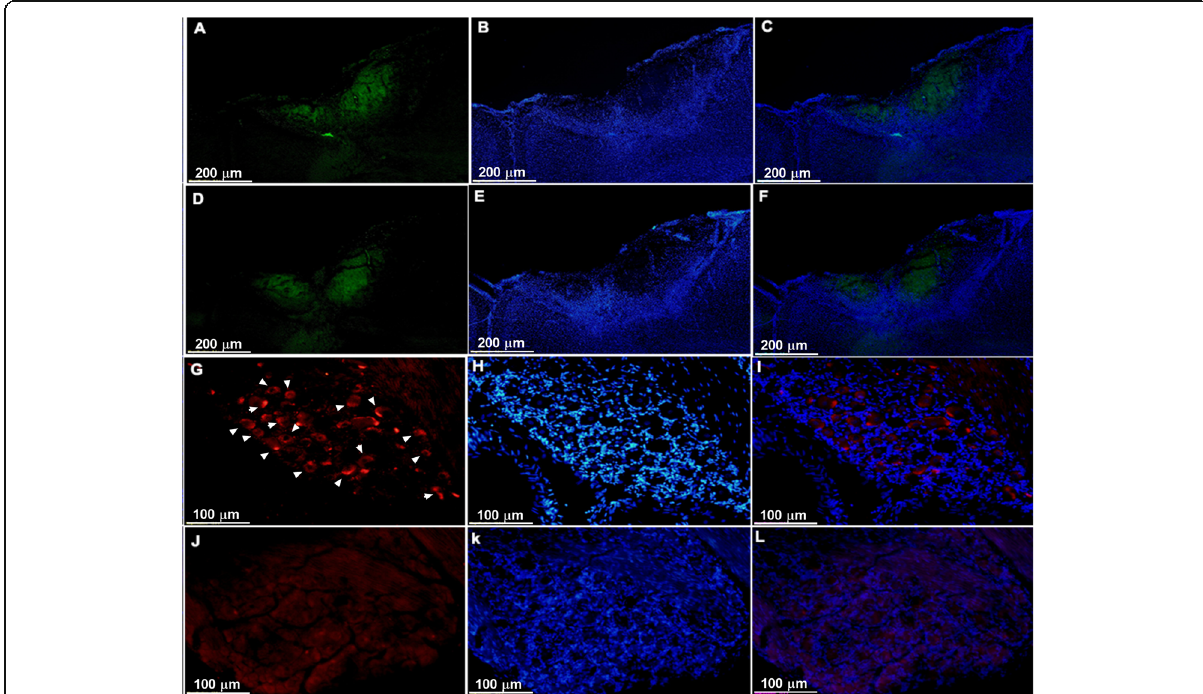
Fig. 7 Immunofluorescence results for viral expression in the primary motor cortex ( a - f ) and CGRP neuron expression in the trigeminal ganglion ( g - l ). a , b , c Optogenetic viral expression in the motor cortex of TN-Opto animals. d , e , f Null viral expression in the motor cortex of TN-Null animals. a , d EYFP, b , e DAPI, and c , f Merge. Scale bar = 200 μ m. g - l PBS and α -CGRP-injected and DAPI-stained trigeminal ganglion cells. g-i Presence of anti-CGRP antibody binding due to active state of α -CGRP neuron (arrow) within the trigeminal ganglion of PBS injected animal ( j - l ). α -CGRP injected and DAPI-stained trigeminal ganglion cells showing absence of CGRP neurons due to inhibition of α -CGRP neurons within the trigeminal ganglion. g , j CGRP, h , k DAPI, and i , l Merge. Scale bar = 100 μ